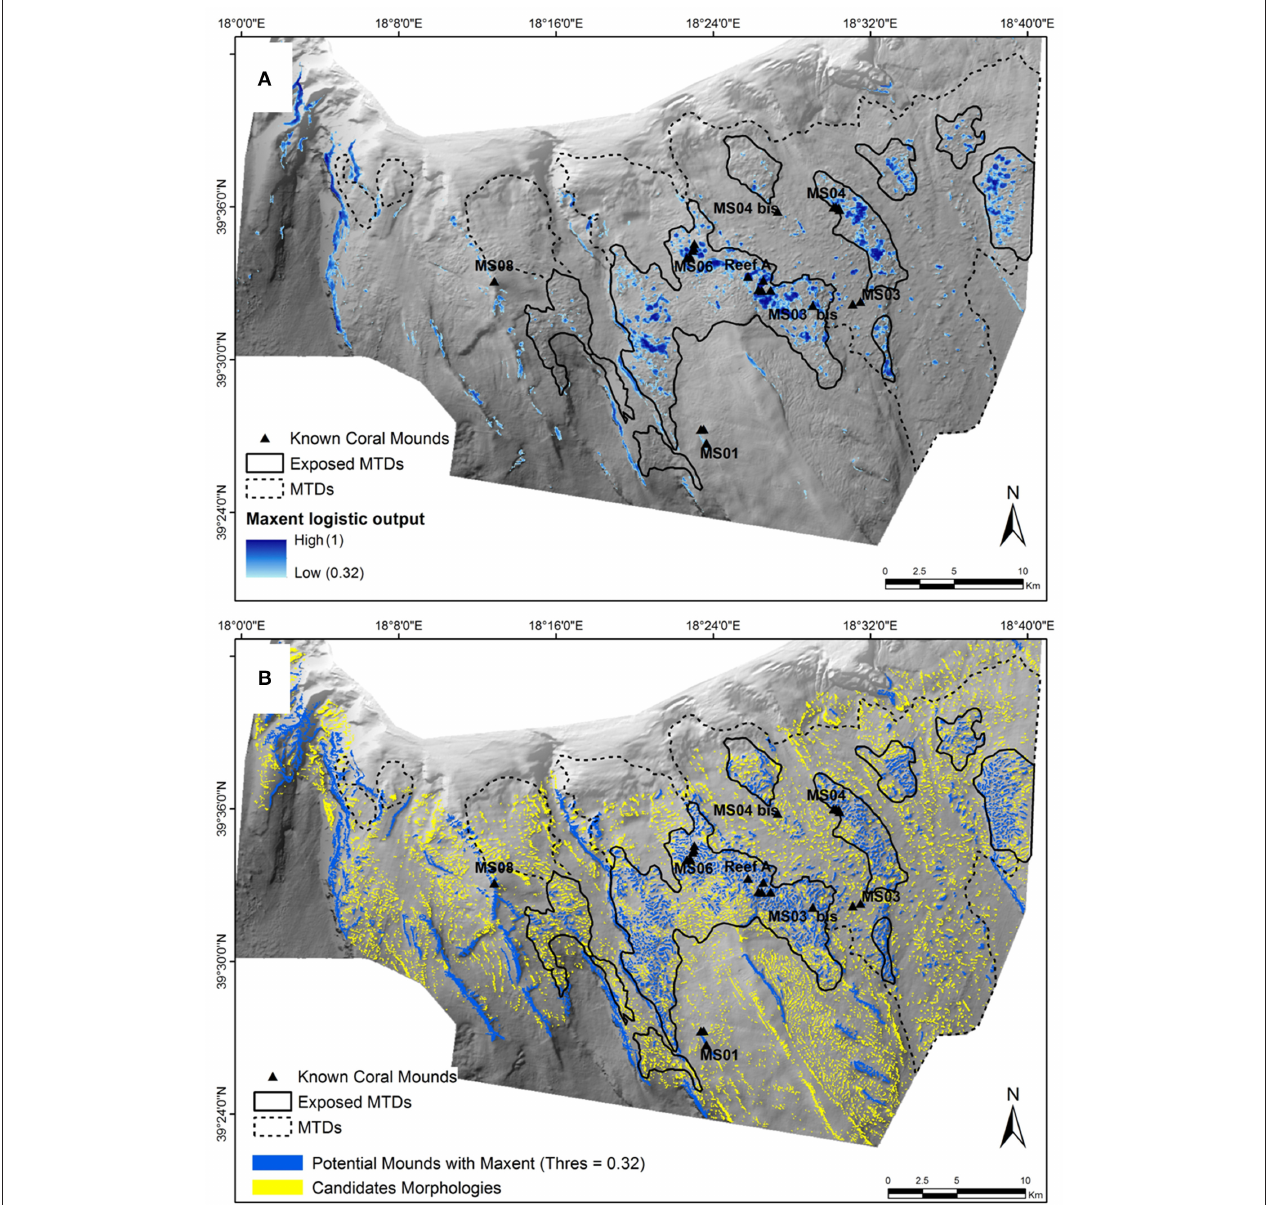
FIGURE 5 | Maps of predicted distributions for Cold-Water Corals in the SML Province using the Maxent method. (A) Distribution of probable coral presence pixels determined by a threshold of logistic outputs of 0.32. (B) Polygons of the 7,447 candidate morphologies [BPI (3 pixels) > 1; in yellow] and the 1,252 potential coral mounds (in blue) intersecting the Maxent polygons obtained with a logistic threshold of